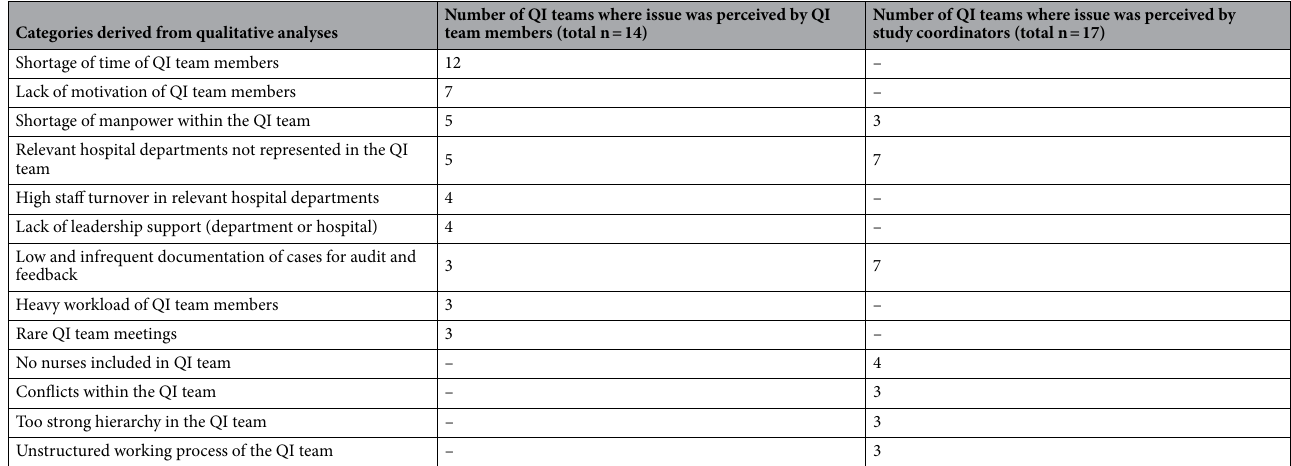
Table 3. Barriers to implementation of quality improvement as perceived by quality improvement teams and study coordinators. Results of qualitative analyses of open-ended questions distributed to study coordinators after each educational session with quality improvement (QI) teams of intervention hospitals during implementation phase and of open ended questions distributed to QI teams of intervention hospitals during the second half of the implementation phase. Data by QI teams were available for 14 QI teams, data by study coordinators were available for 17 QI teams. Every category was only counted once per QI team per data source. Only categories present among at least three QI teams are